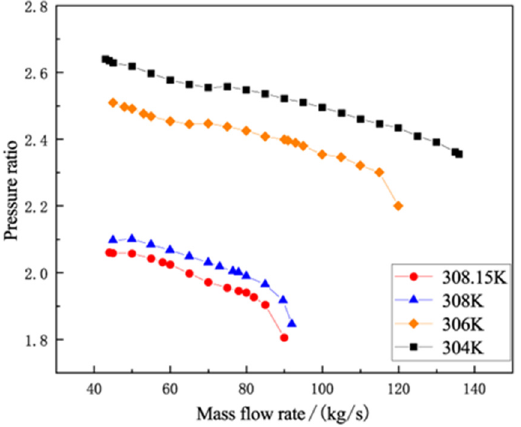
Figure 7. Pressure ratio versus mass flow rate at various inlet temperatures.